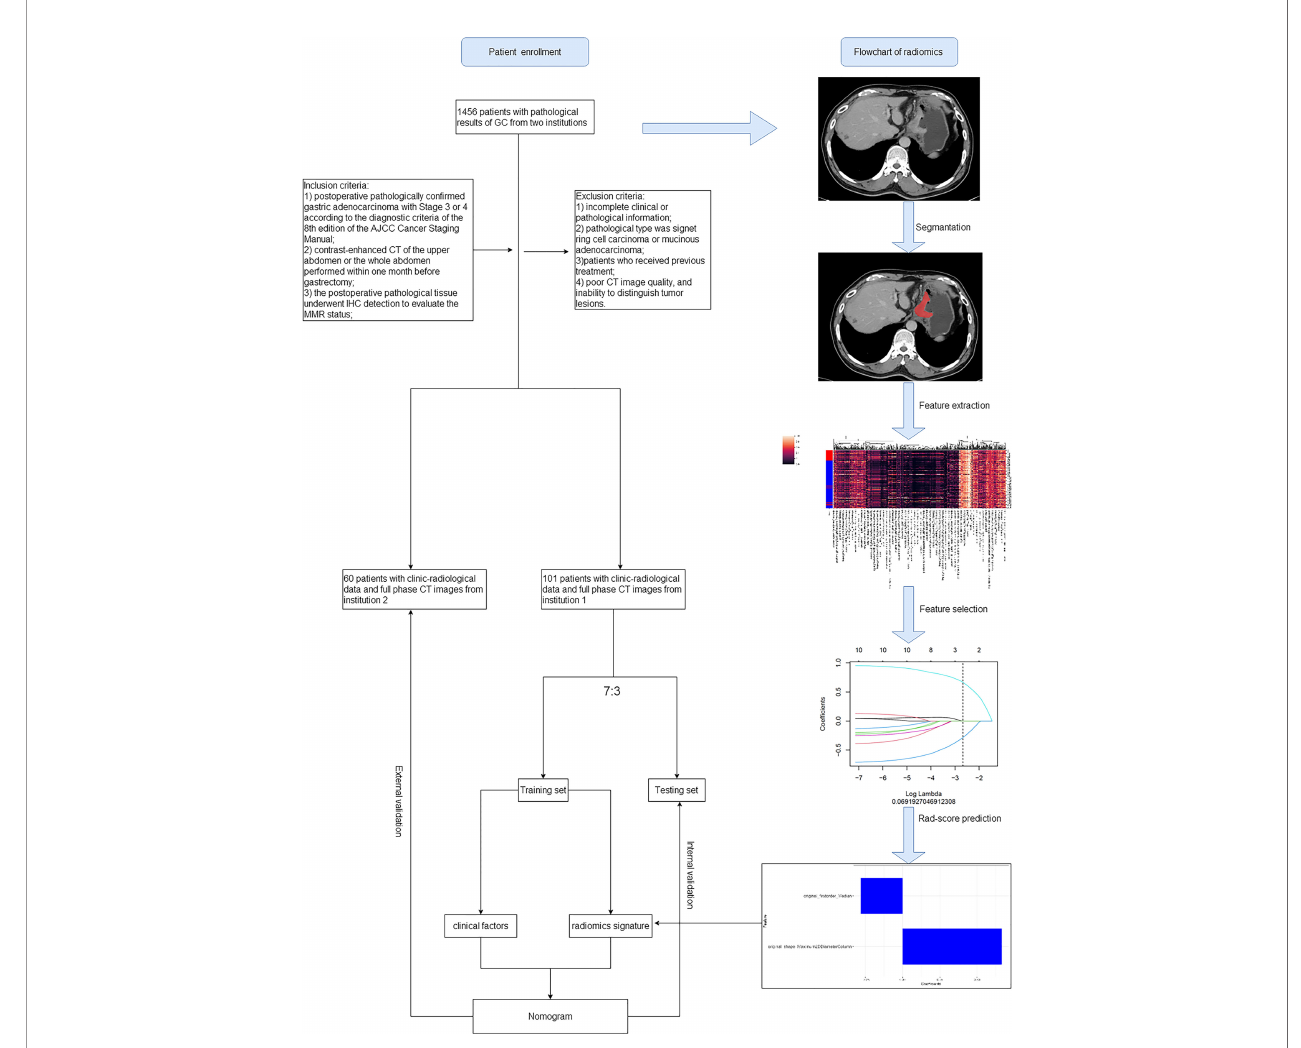
FIGURE 1 | Flowchart of the recruiting study population and model